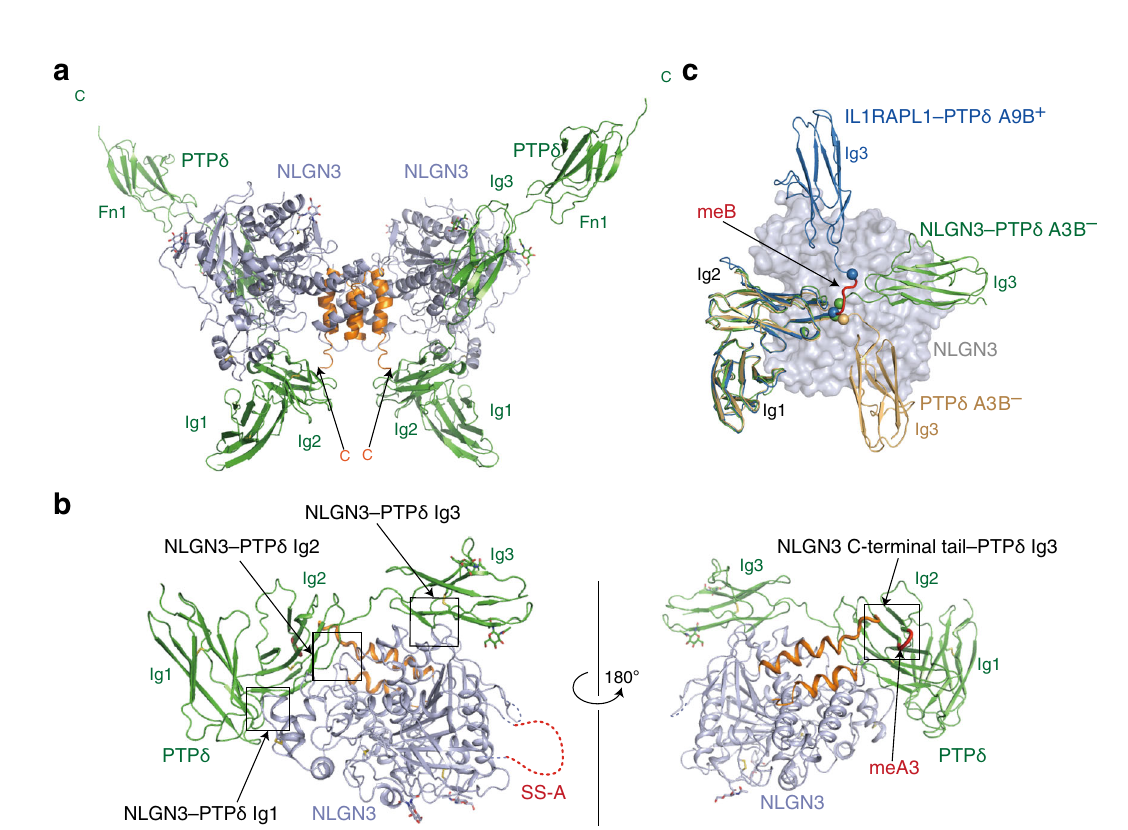
Fig. 3 Structure of the NLGN3 – PTP δ A3B – complex. a Overall structure of the NLGN3 ECD – PTP δ A3B – Ig1 – Fn1 heterotetrameric complex. Two NLGN3 molecules are purple, except that their C-terminal regions containing two dimerization helices are orange. Two PTP δ molecules are colored in green. b Binding interfaces between NLGN3 and PTP δ A3B – . The individual interfaces are indicated by boxes. The coloring scheme is the same as that in ( a ), except that the meA3 insertion in PTP δ is red. PTP δ Fn1 is not shown for clarity. c Superposition of the NLGN3-bound PTP δ A3B – Ig1 – Fn1 (green), apo- PTP δ A3B – Ig1 – Fn2 (PDB 4YFG; beige), and IL1RAPL1-bound PTP δ A9B + (PDB 4YH6; blue) using PTP δ Ig1 – Ig2 as the reference. The bound NLGN3 is shown of PTP δ A9B + Arg233 and Val238, which fl ank the meB insertion, are shown as spheres. Arg227 and Val228 of PTP δ A3B – (equivalent to Arg233 and Val238 of PTP δ A9B + , respectively) are also shown as Fig. 5b). Leu141, Pro221, and Tyr225 of PTP δ Ig2 form a PTP δ A3B – and NLGN3 form a W-shaped complex with a hydrophobic interface with Tyr302, Val305, and Ile355 in the 2:2 stoichiometry (Fig. 3a and Supplementary Fig. 5a). α / β -hydrolase-fold core of NLGN3 (Fig. 4b and Supplementary The Ig1 – Ig3 domains of PTP δ interact extensively with the α / β -hydrolase-fold core of NLGN3 (Fig. 3b, c). The Ig2 domain of Fig. 5c). In addition, the C-terminal tail of NLGN3 ECD lies on the meA3 insertion in PTP δ Ig2 (Fig. 4c and Supplementary PTP δ also contacts the C-terminal tail of NLGN3 ECD (Fig. 3b). Fig. 5d). The C-terminal tail of NLGN3 ECD is disordered in the The NLGN3 – PTP δ interface buries a surface of 1540 Å 2 in total. Phe170 and the aliphatic portions of Arg75, Glu77, Arg90, and apo-NLGN3 ECD structure, suggesting that it undergoes a Gln92 in PTP δ Ig1 form a hydrophobic pocket to accommodate disorder-to-order transition upon binding to PTP δ . Met614 and the side chain of Leu320 in NLGN3 (Fig. 4a and Supplementary Phe615 of NLGN3 appear likely to form hydrophobic interactions